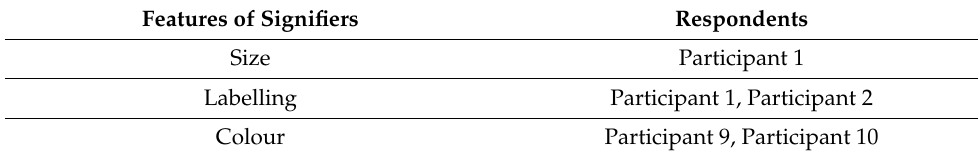
Table 7. Suggested features by test participants to integrate into museum